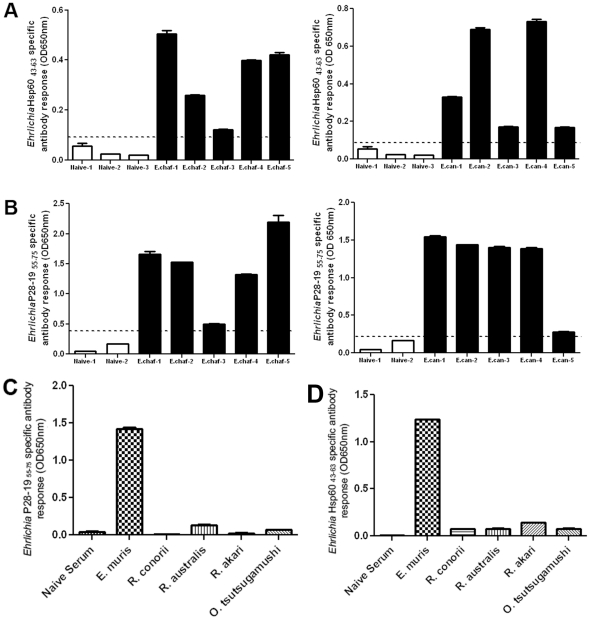

Ehrlichia Hsp60 43–63 and P28-19 55–75 peptides reacted with Ehrlichia-specific antibody from dogs infected with E. canis and E. chaffeensis.(A) Ehrlichia Hsp60 43–63 peptide reacted with antibodies from five dogs infected with E. chaffeensis and five dogs infected with E. canis. (B) P28-19 55–75 peptide reacted with antibodies from five dogs infected with E. chaffeensis and five dogs infected with E. canis. Each bar represents the mean of three replicates. The horizontal line in the graphs represents Mean + 3 SD of negative samples. The positive samples are significantly different from negative samples. (C) P28-19 55–75 peptide did not react with antibodies from mice infected with Rickettsia or Orientia. (D) Ehrlichia Hsp60 43–63 peptide did not react with antibodies from mice infected with Rickettsia or Orientia.